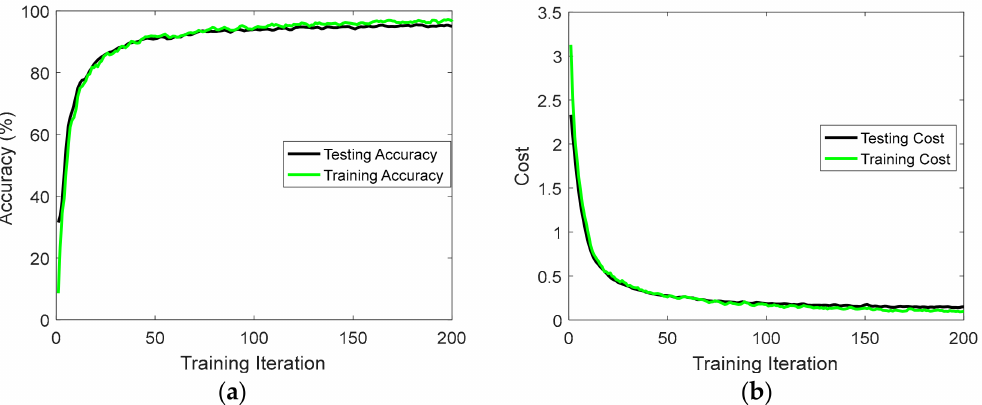
Figure 7. Accuracy and cost of the unidirectional DRNN model for the USC-HAD dataset over mini-batch training iterations: ( a ) training and testing accuracies; ( b ) cross-entropy cost between ground truth labels and predicted labels for both training and